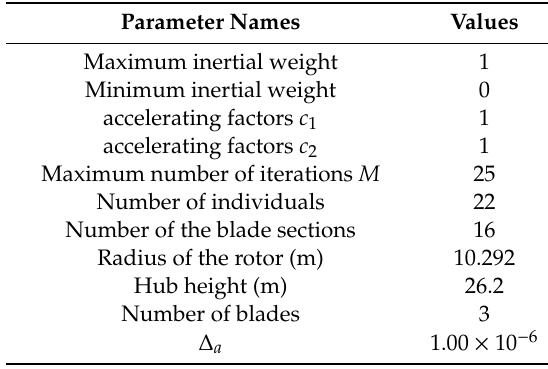
Table 2. Some typical parameters used in this optimization